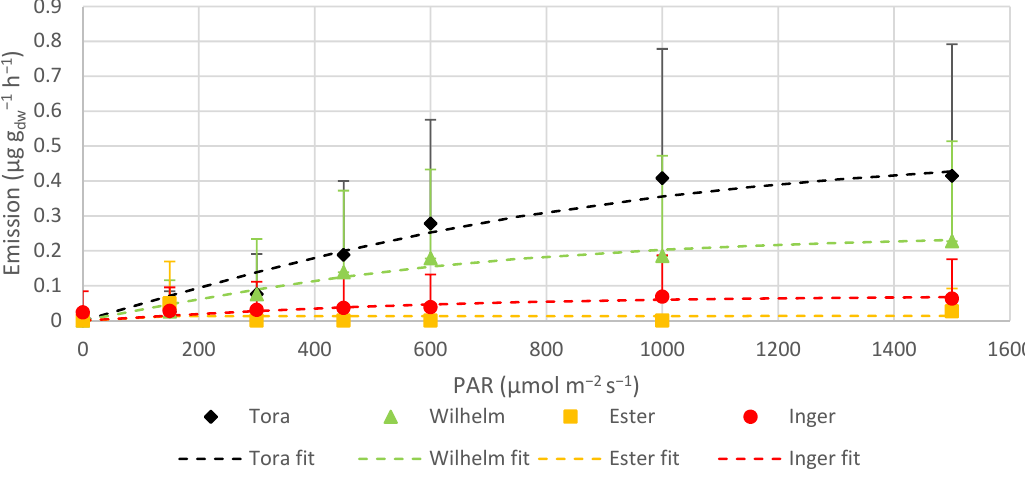
Figure 7. The light response of ocimene emissions (µg g dw − 1 h − 1 , mean + standard deviation, n = 7–16) to different PAR values (µmol m − 2 s − 1 ) for the Salix varieties.